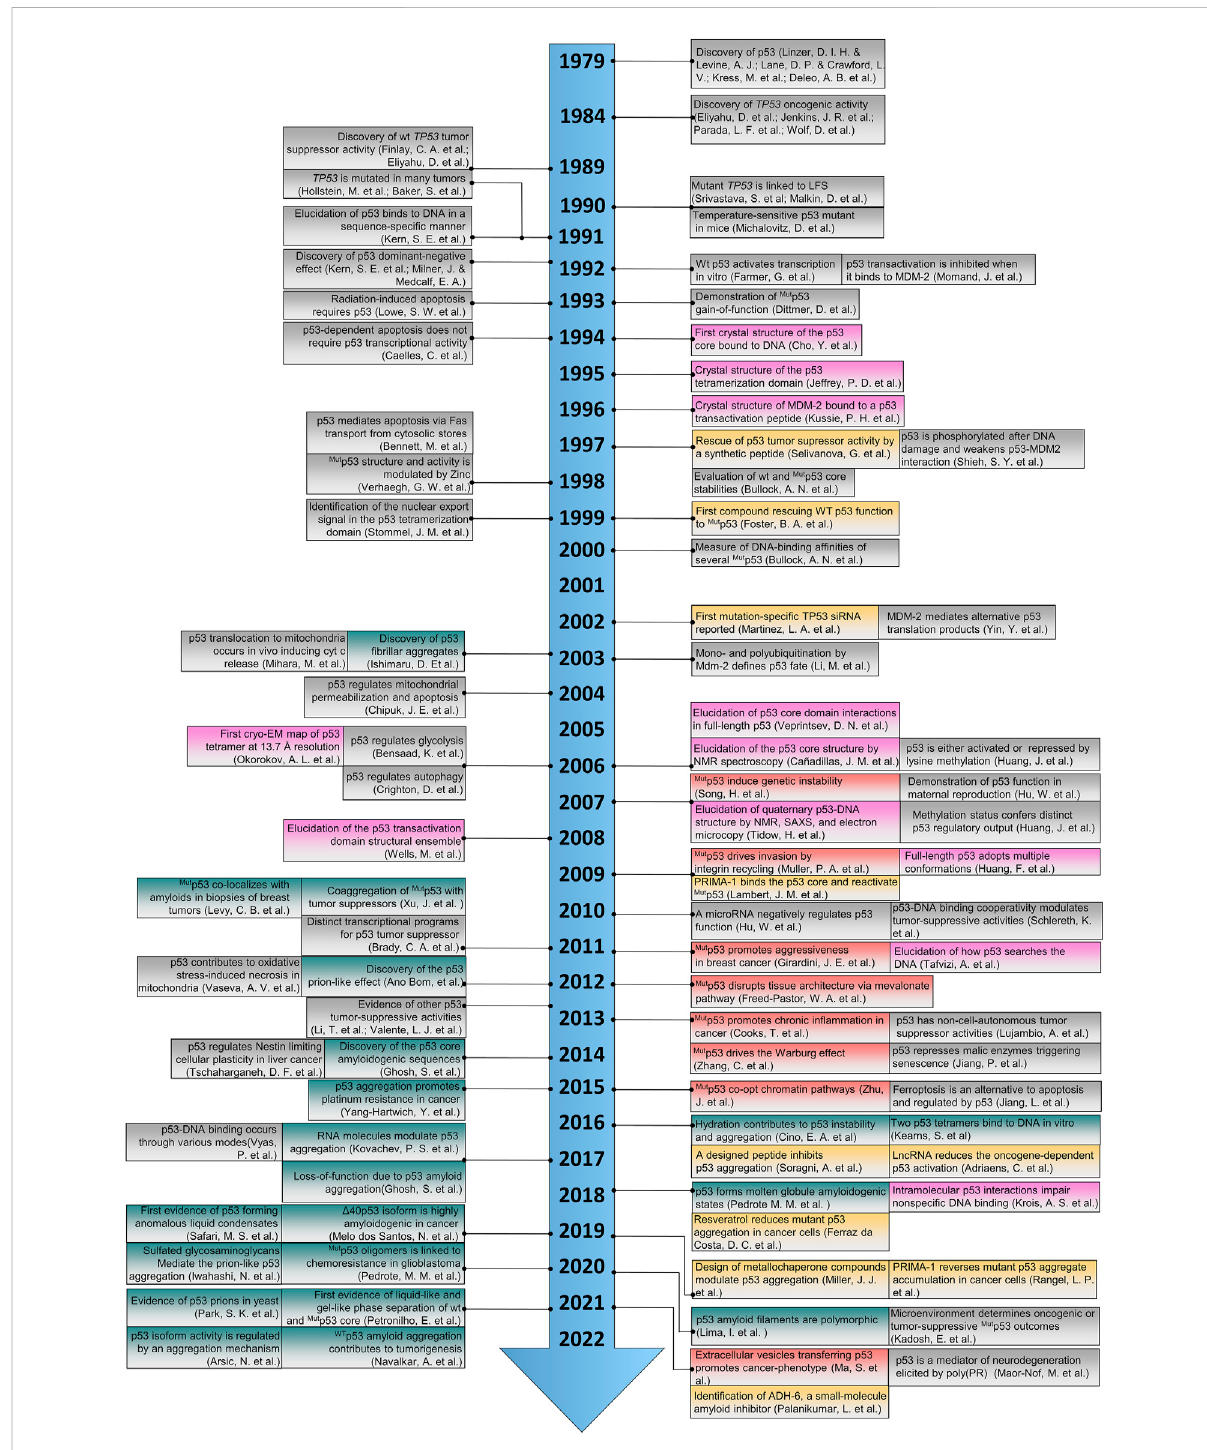
FIGURE 1 The timeline illustrates what the authors consider the most disruptive contribution in the p53 research over the last 40 years. Color coding shows seminal and breakthrough discoveries (gray), structural biology contribution (pink), therapeutic strategies (yellow), p53 gain-of-function examples (red), and p53-HOS research (green). We apologize to our colleagues in the p53 fi eld whose work was not cited due to space limitations. Referencesincludedinthetimelinebutnotmentionedinthetext:(Michalovitz